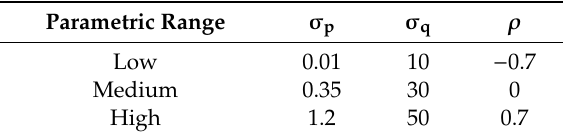
Table 3. Range for the wholesale log-price standard deviation σ p , the quantity standard deviation σ q , and the wholesale log-price and quantity correlation ρ